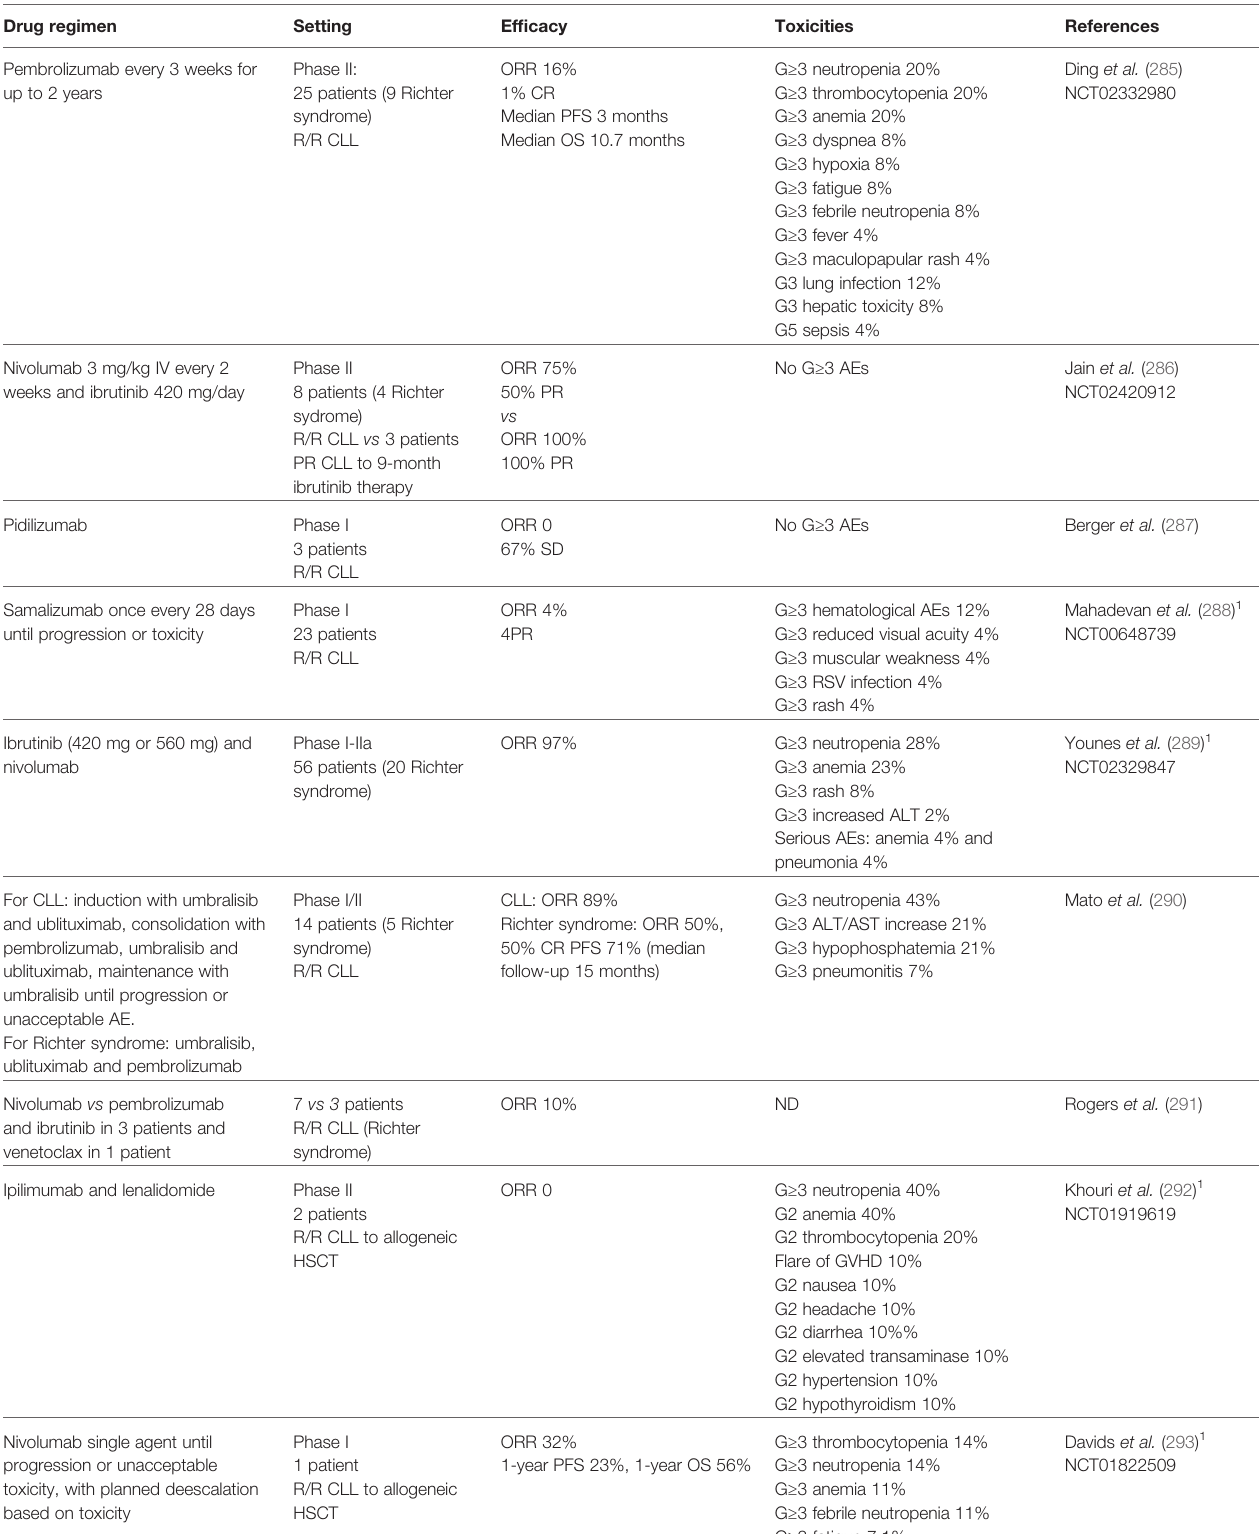
TABLE 4 | Clinical trials evaluating the ef fi cacy and toxicity of immune checkpoint inhibitors, used as single agents or in combination regimens, for the treatment of patients with CLL. Drug